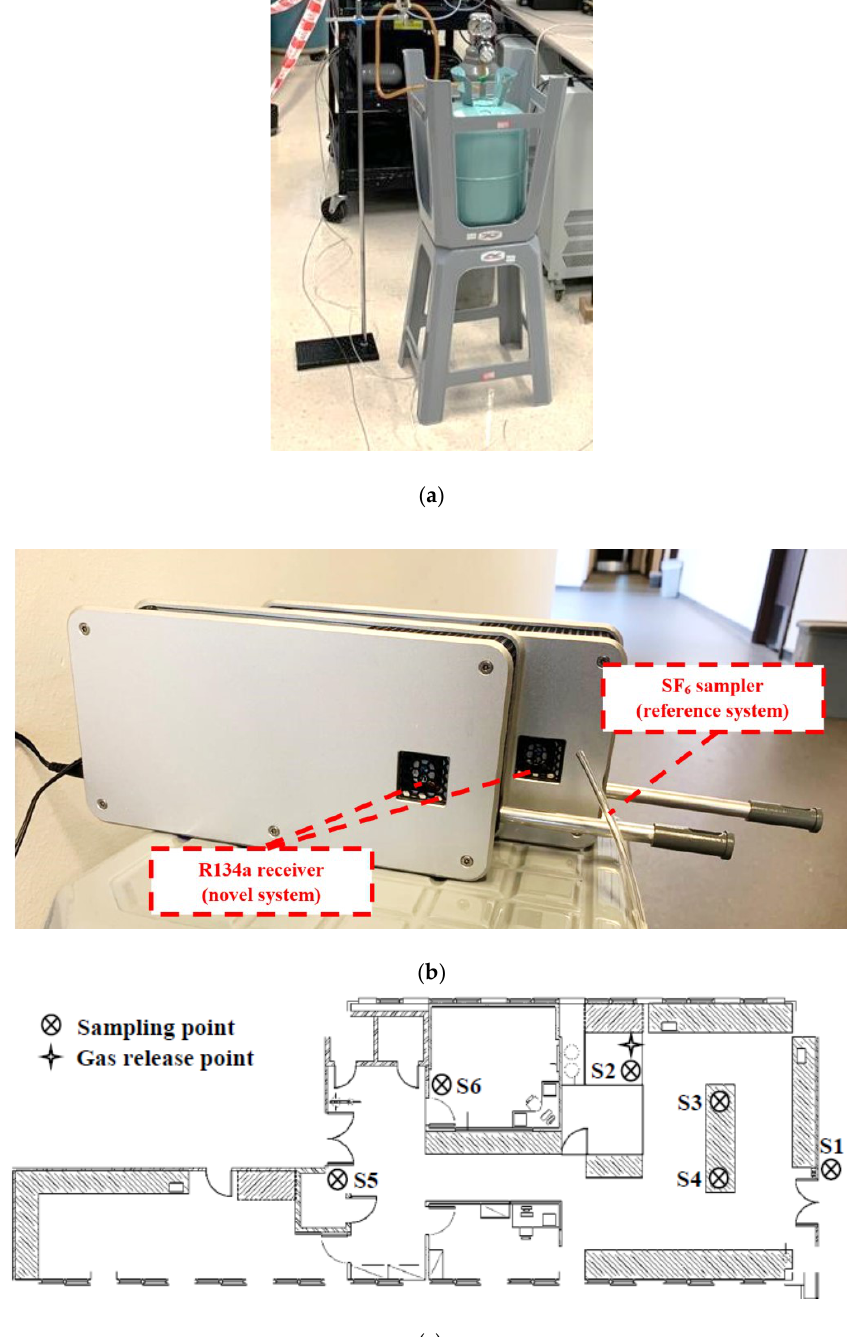
Figure 2. ( a ) Photograph of the experimental setup for the release of SF 6 and R134a; ( b ) photograph of the sampling tube for SF 6 measurement (the reference system) and the receivers for R134a measurement (the novel system); ( c ) layout of the testing laboratory with sampling and gas release point locations.